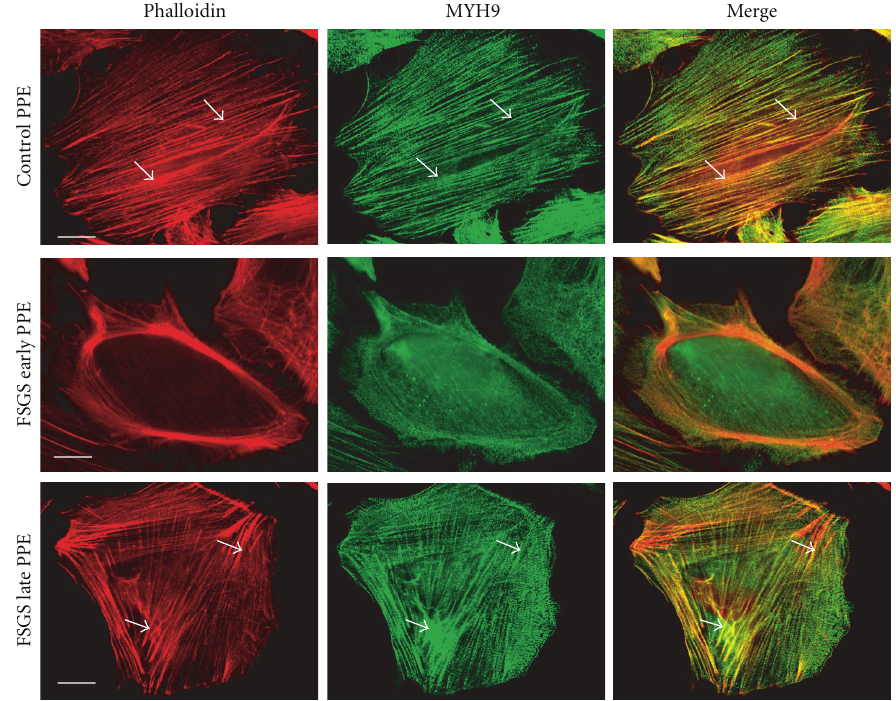
Figure 2: Plasmapheresis e ffl uent from a patient with a recurrent FSGS disrupts the cytoskeleton of human podocytes in culture. Immor- talized human podocytes (gift from Dr. Saleem) were incubated for 6 hours with 10% plasmapheresis e ffl uent from a control patient undergoing plasmapheresis for a nonrenal disease (upper panel); PPE from a patient with recurrent FSGS collected at the start of procedure (middle panels, “early PPE”); end of plasmapheresis (lower panels, “late PPE”). The “early PPE,” but not the late PPE FSGS sample disrupts polymerized actin (phalliodin staining, red) and nonmuscle mysosin II (staining with anti-MYH9 antibody-green); arrowheads: actin stress fibers; scale bar